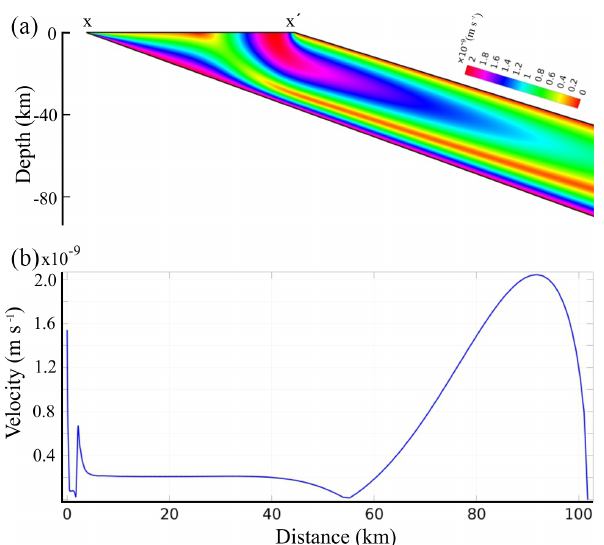
Figure 7. (a) Velocity map of a channel under transpression. X − X (cid:48) marks the line along which extrusion velocity was measured and plotted in (b)